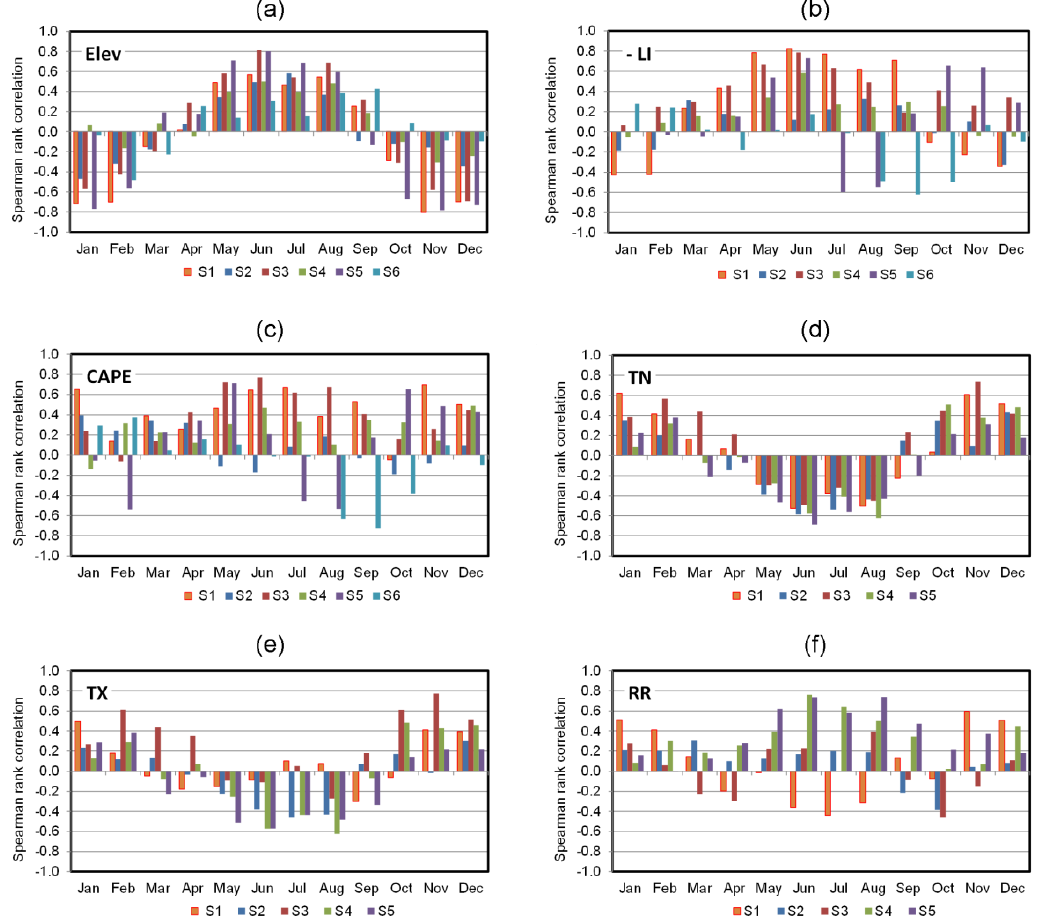
Fig. 6. Spatial Spearman rank correlations between (a) Elev, the 7yr (2003–2009) monthly means of (b) − LI, (c) CAPE, (d) TN, (e) TX and Figure 6: Spatial Spearman rank correlations between (a) Elev, the 7-year (2003-2009) 818 (f) RR and the corresponding monthly means of the total CGF occurrences for each of the six subsectors (S1–6). monthly means of (b) -LI, (c) CAPE, (d) TN, (e) TX and (f) RR and the corresponding 819 Although these results support previous considerations based monthly means of the total CGF occurrences for each of the six subsectors (S1-6). 820 on Fig. 4, they also hint at the relevance of the tropospheric western-central and northern